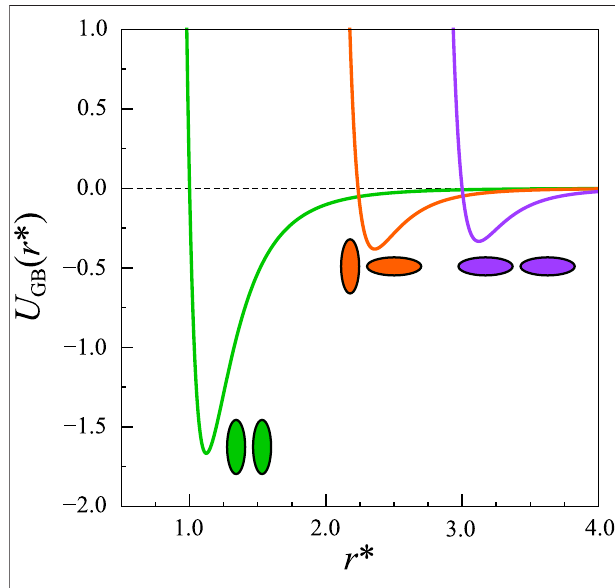
FIGURE 2 | Intermlecular potential for the GB ( 3 , 5 , 2 , 1 ) mesogen as a function of intermesogen distance. Representative mesogen arrangements are highlighted to emphasize how U GB ( r ) is tempered according to relative mesogen-mesogen orientation.